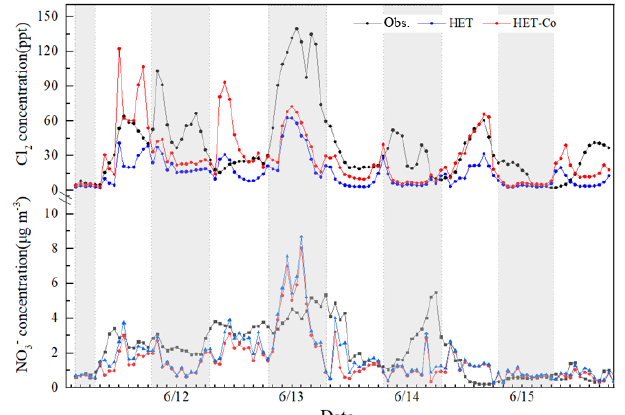
Figure 2. Comparison of observed and predicted Cl 2 and NO − centrations under different uptake coefficient of O 3 (HET: daytime = 1 × 10 − 3 , nighttime is γ is γ O 3 = 1 × 10 − 2 , nighttime is γ is γ O 3